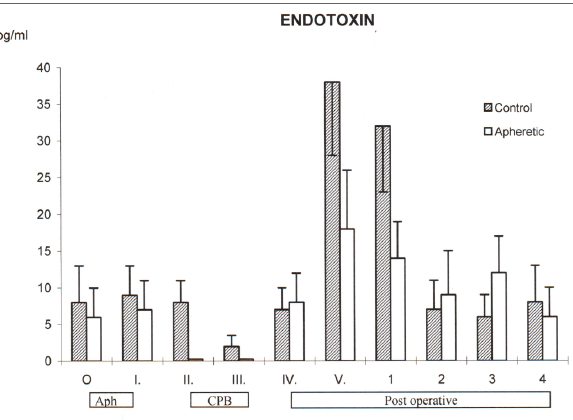
Fig. 2. endotoxin levels. 0: before aphaeresis-filtration, i: after aphaeresis-filtration, ii: 10 min. after starting cpB, iii: after stopping cpB, iV: after skin suture, V: 6 h postop. 1-4: postop. days. stripped bars: control group; open bars: aphaeretic group. in the controls, endotoxin levels increased at two time points: 6 h postoperatively and on the morning of the next day compared with preoperative levels ( P < 0.001 for time point 0 versus points V. and 1 by one-way analysis of variance). in the aphaeretic group, endotoxin also increased significantly com- pared with preoperative levels but was lower than in the controls ( P < 0.05 control versus aphaeretic group at time points V. and 1 by two-way analysis of variance for repeated